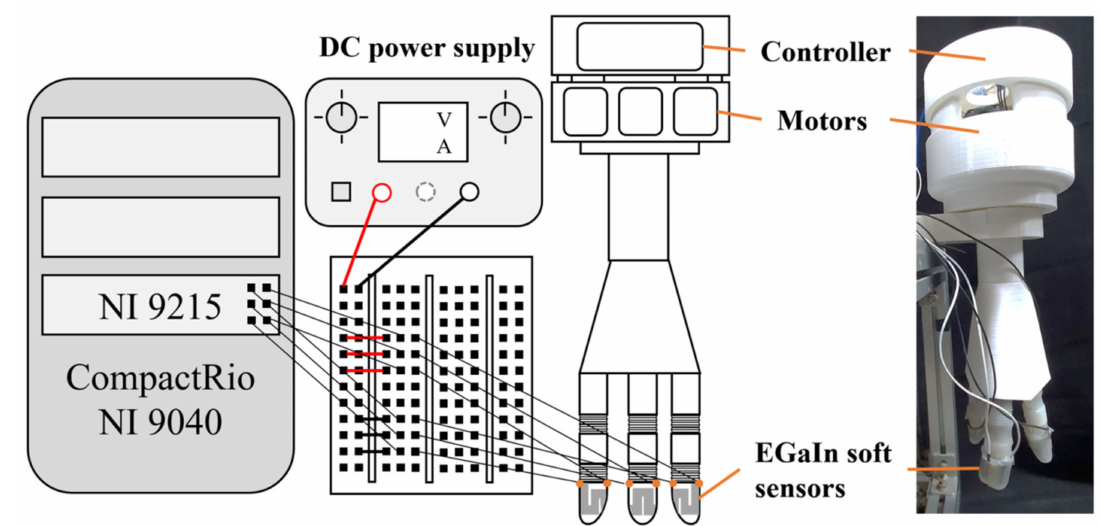
Figure 9. Illustration of the experimental setup for characterizing the variable-stiffness soft gripper.